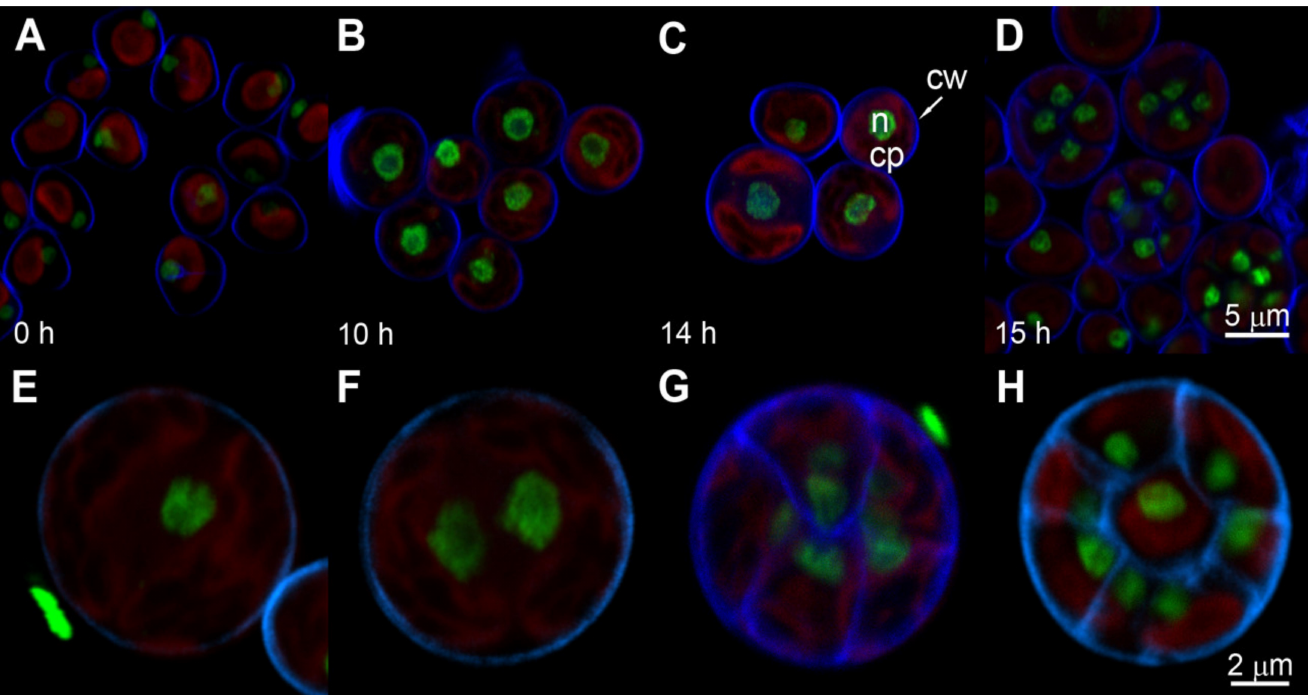
Figure 4. Fluorescent photo-micrographs of synchronized cells of Parachlorella kessleri grown in light at 250 µ mol photons m − 2 s − 1 and a temperature of 30 ◦ C at 0 h ( A ), 10 h ( B ) , 14 h ( C ) and 15 h ( D ) of the cell cycle. Magnified cells show dividing nuclei, chloroplasts and protoplasts into 2 ( E , F ), 8 ( G ) and 16 ( H ) daughter cells. To visualize nuclei, the cells were stained by fluorescent dye SYBR Green I dye, the cell walls were stained by calcofluor (Fluorescent Brightener 28) dye. Green stained nucleus, n; red autofluorescence of chloroplast, cp; blue stained cell wall, cw and arrow. Scale is 5 µ m for ( A – D ), and 2 µ m for ( E – H